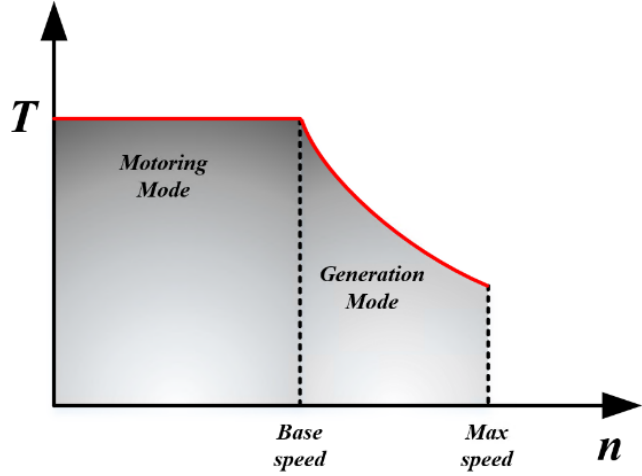
Figure 1. Schematic of torque-speed characteristics.